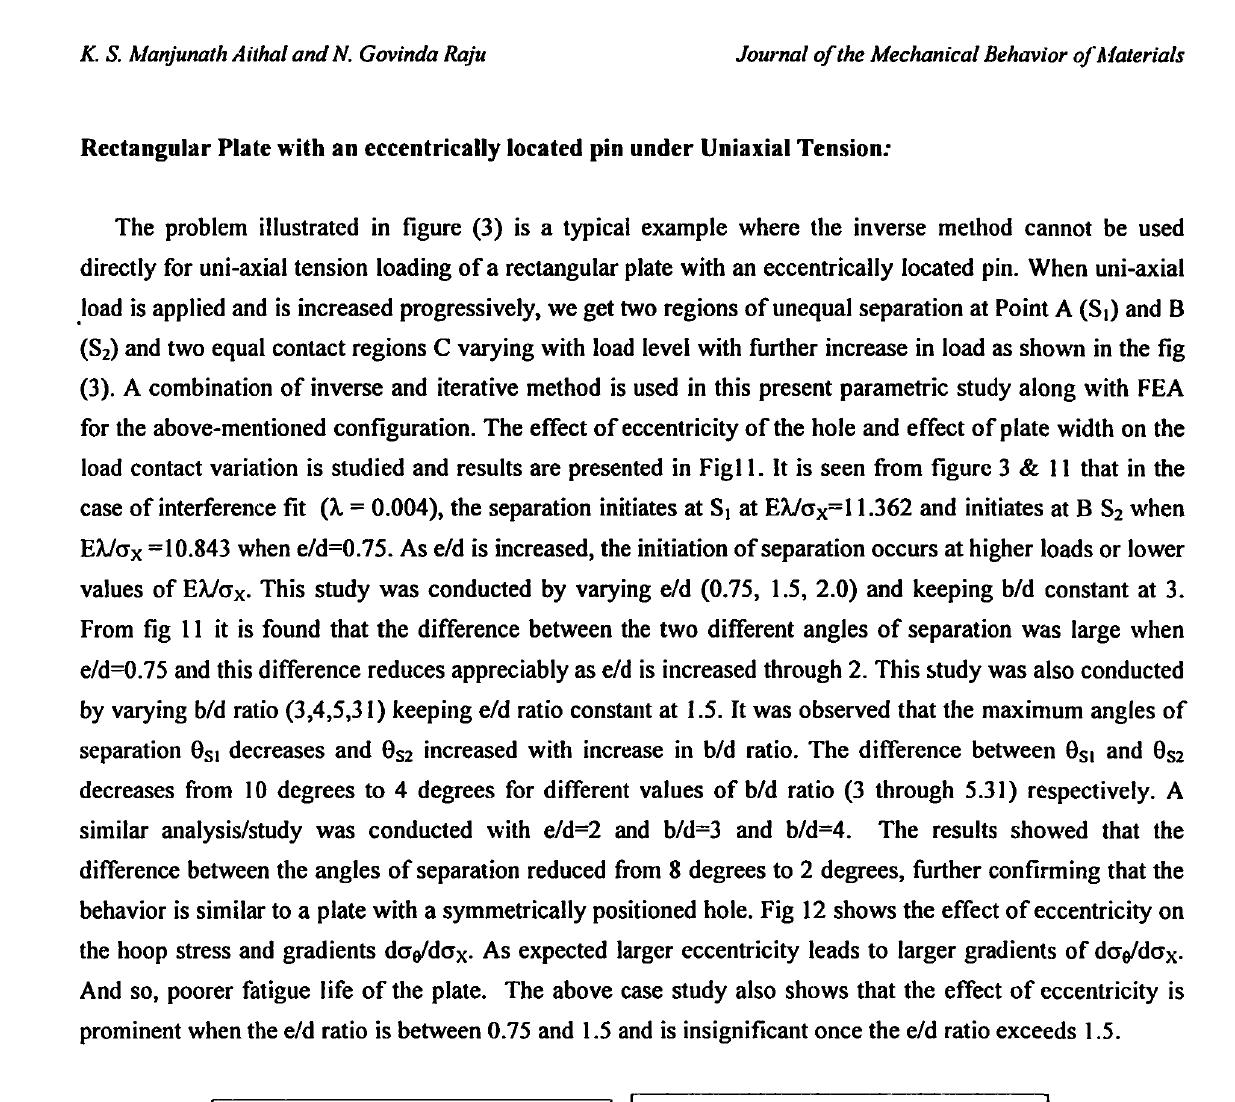
Variation of hoop stress with applied load, effect of eccentricity (e/d - 0 75, 1 5, 2, b/d = 3. and H/d